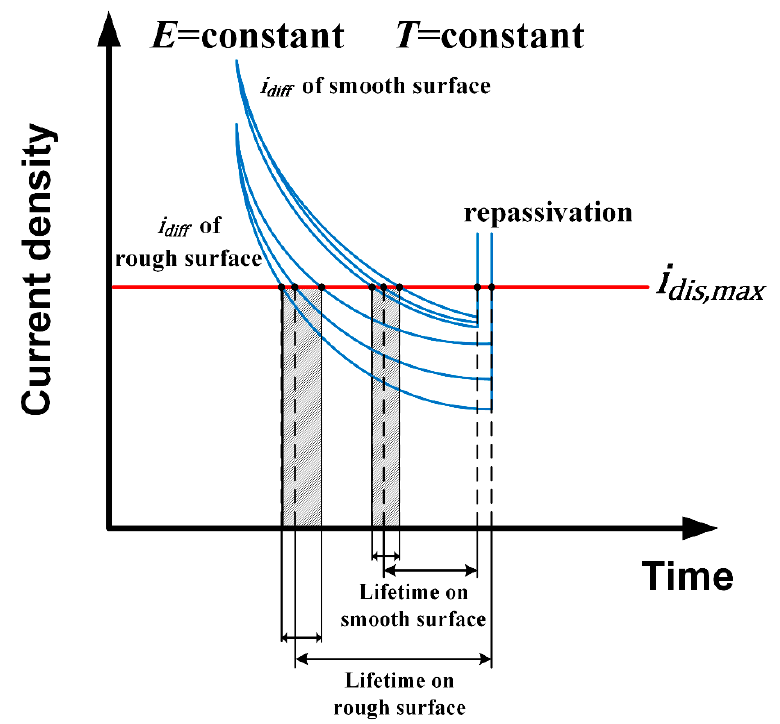
Figure 17. Schematic presentation of the relationships between surface roughness, idiff, idis,max, and lifetime of a metastable pit.